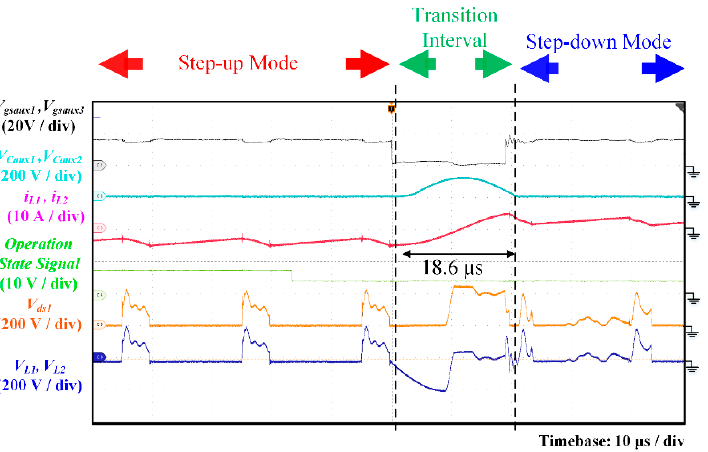
Figure 21. Experimental waveforms of transition from step-down mode to step-up mode under the half-load condition.